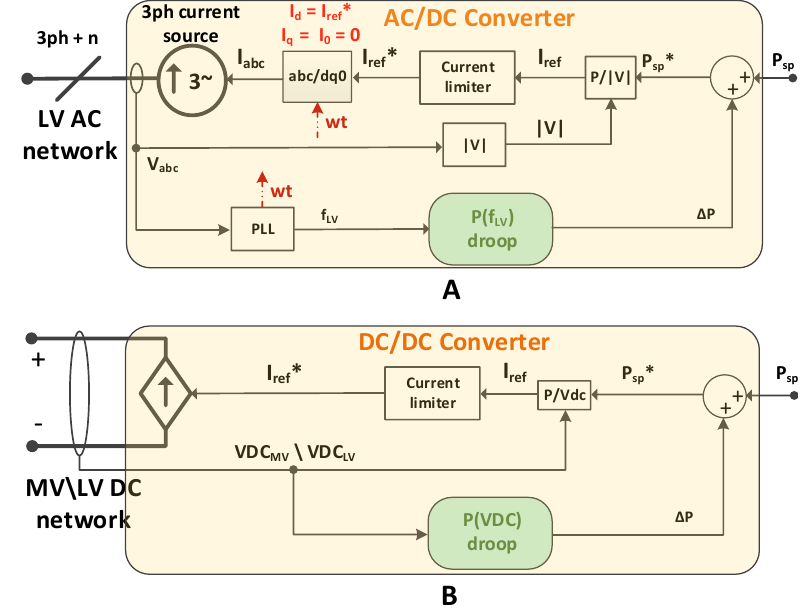
Figure 17. P ( f LV ) and P ( VDC ) droop controllers incorporated in the controllable AC ( A ) and DC ( B ) DER units connected to the hybrid distribution network.